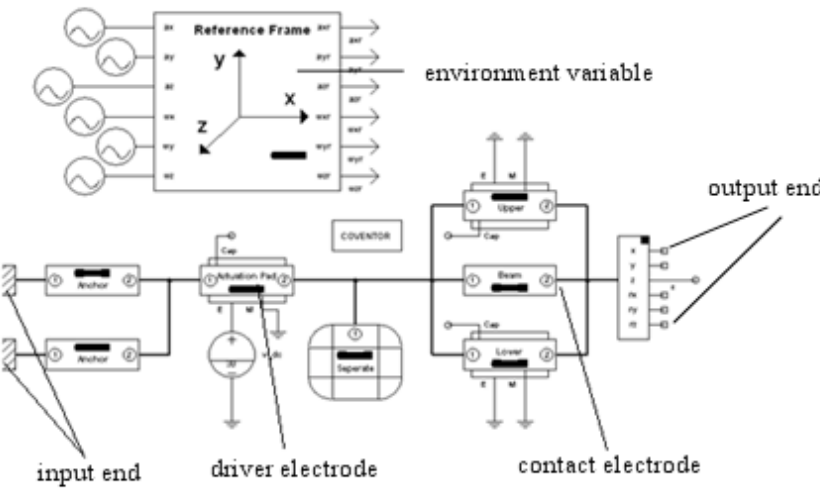
Figure 3. System-level behavioral model in the